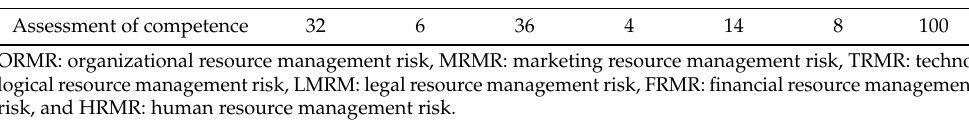
Table 2. Percentage distribution of the six core risk competence areas by management position. Management Position